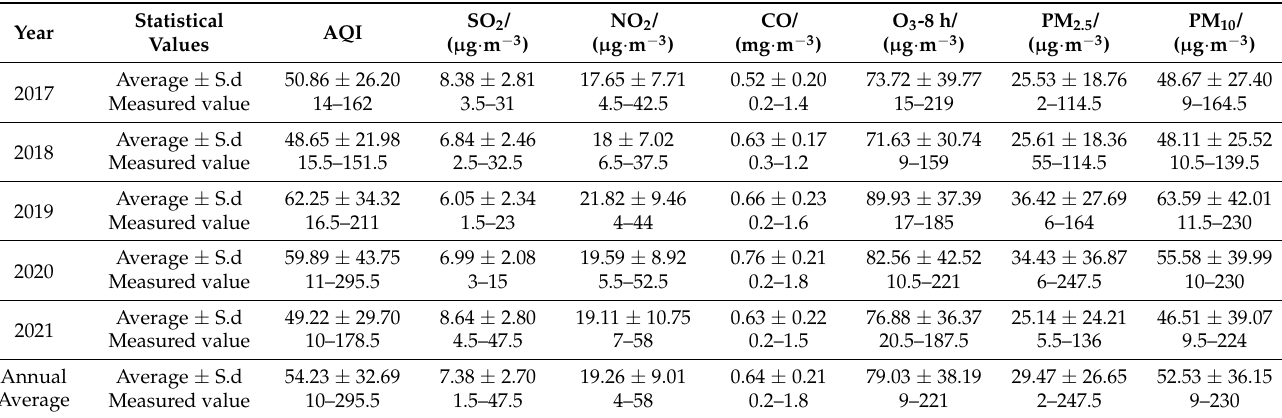
Table 2. AQI and major air contaminants’ concentration